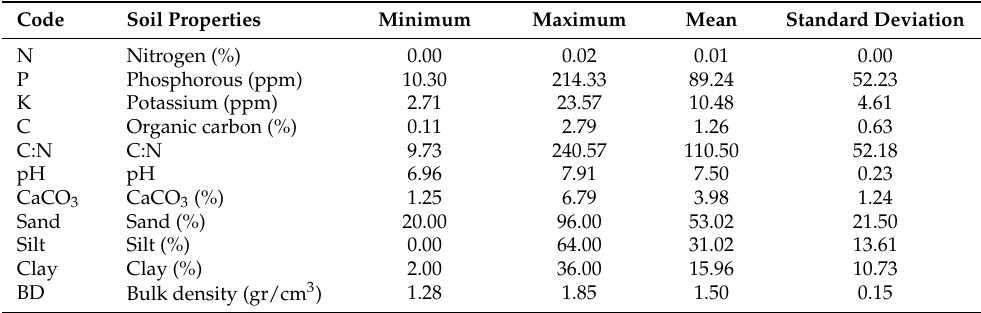
Table 3. Statistical summary of the soil physiochemical properties in the studied